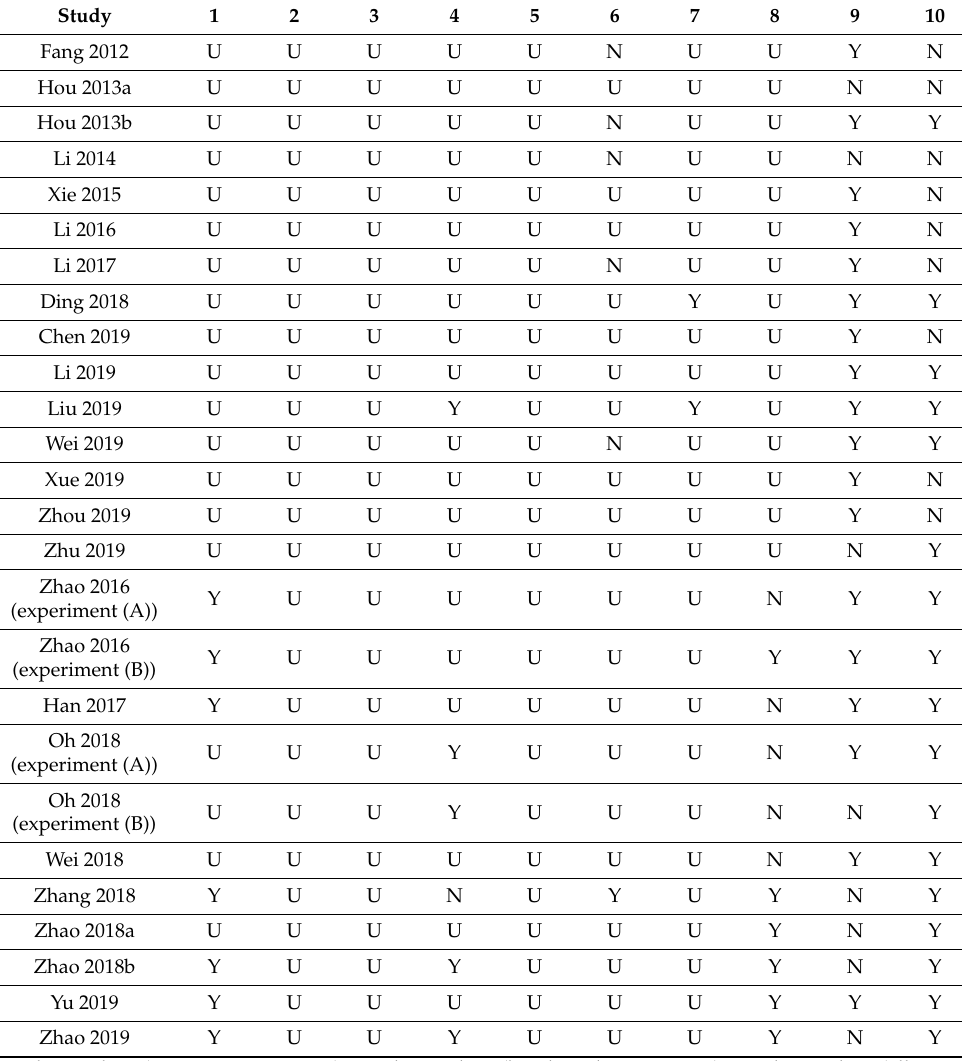
Table A18. SYRCLE Results of Included Animal Studies.